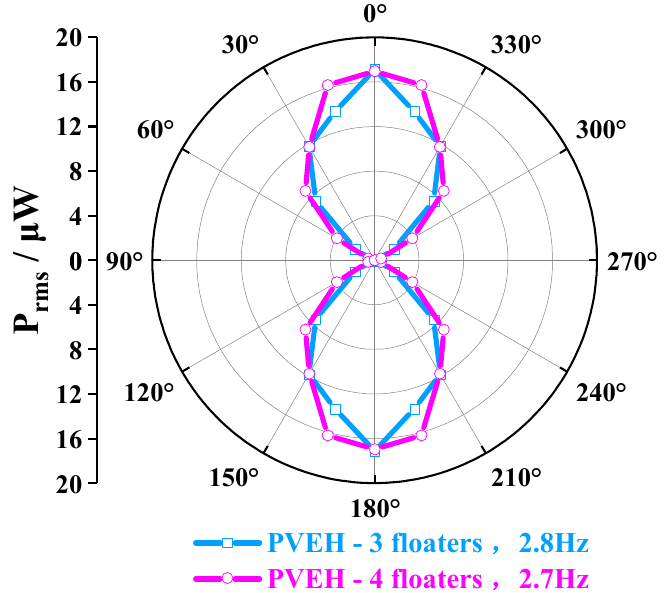
Figure 11. The angular response of PVEH-3 floaters and PVEH-4 floaters in a vertical plane.